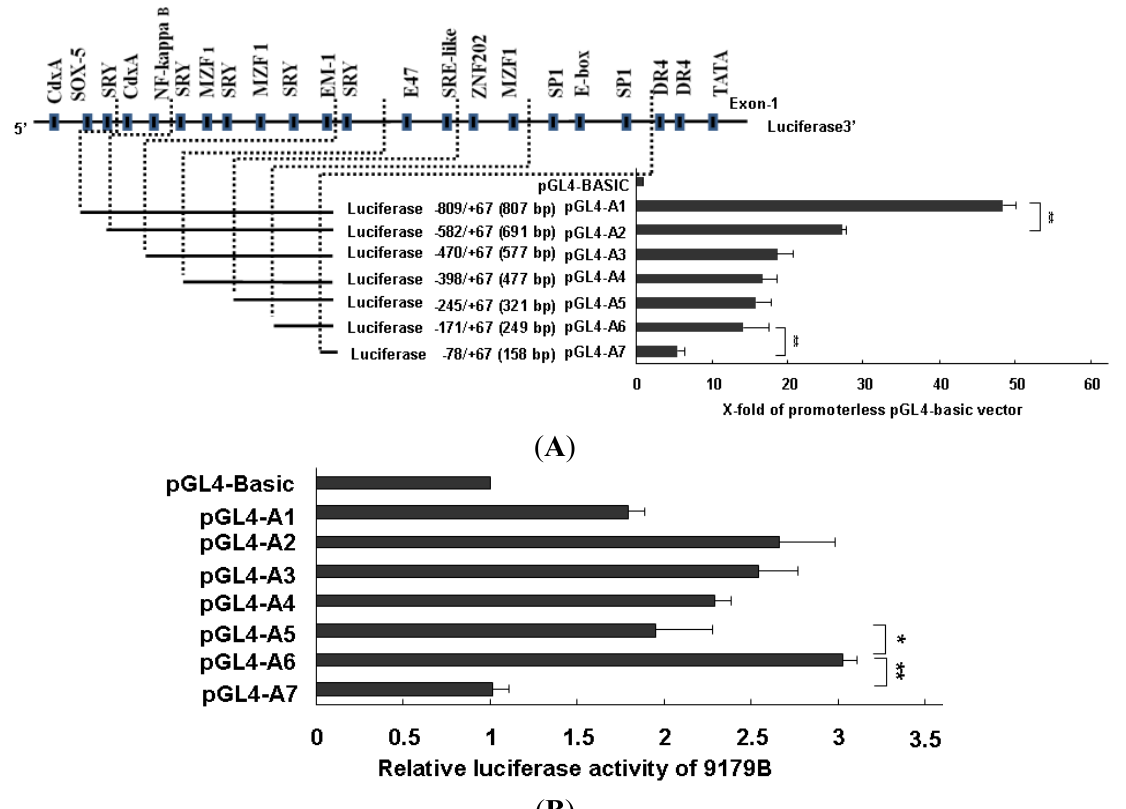
Figure 5. Characterization of the DNA motifs mediating 9179B up-regulation of ABCA1 promoter